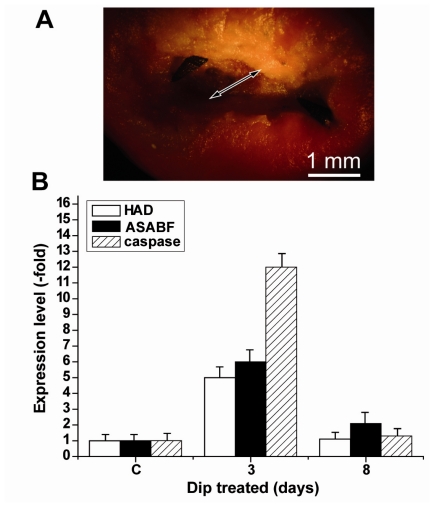
Spatially resolved analysis of the expression level of HAD, ASABF as well as of the caspase gene. Tissue samples from controls as well as samples from within the apoptotic areas (the diameter of the area is given by a double-headed arrow) of Dip-treated specimens were analyzed. The expression is given in arbitrary units as multiple-fold of the transcript levels seen in the controls (non-treated animals; day 0). The analyses were performed by qRT-PCR 3 days and 8 days after exposure of the specimens to Dip using the expression of the tubulin gene as a reference house-keeping gene; the controls remained untreated. The means ± SEM (n = 5) are given.